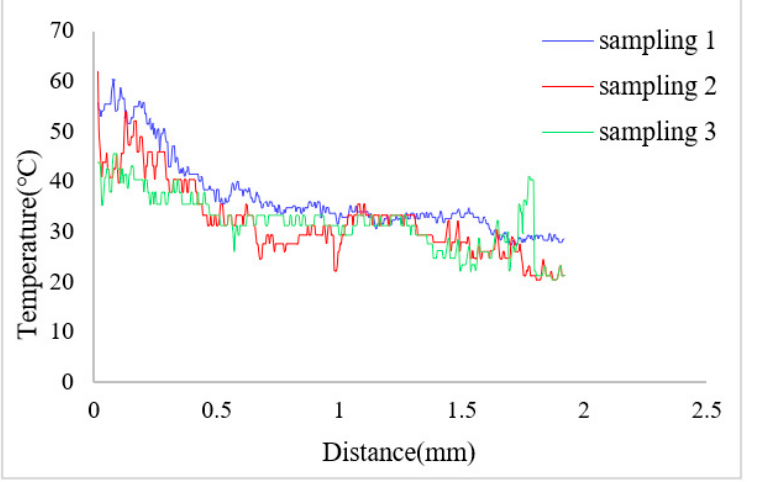
Figure 14. Temperature variation along the mark line (in Figure 10) when the applied apparent power is 6.28 VA.